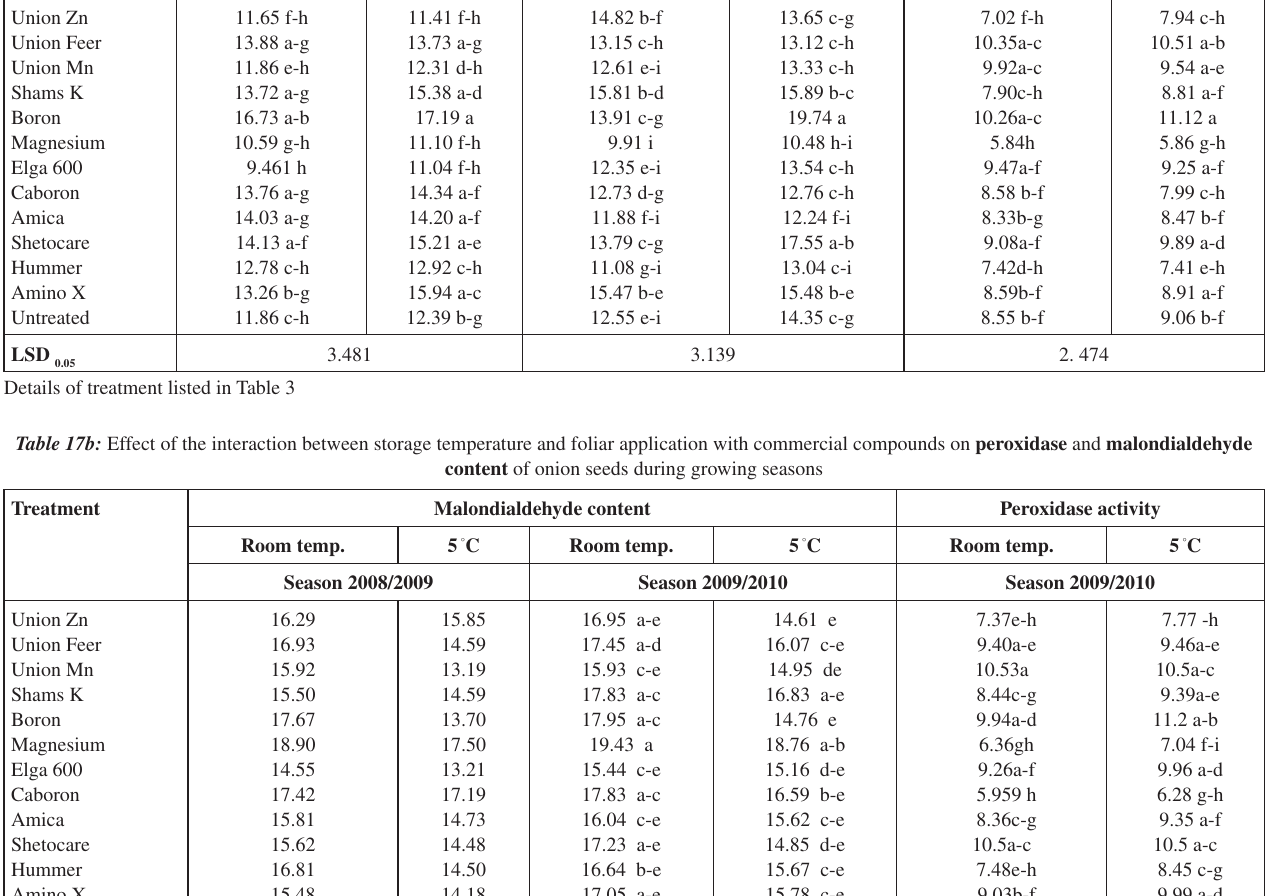
Table 17a: Effect of the interaction between storage temperature and foliar application with commercial compounds on catalase and peroxidase activity of onion seeds during growing seasons Treatment Catalase activity (enzyme unit) Peroxidase activity Room temp. 5 ° C